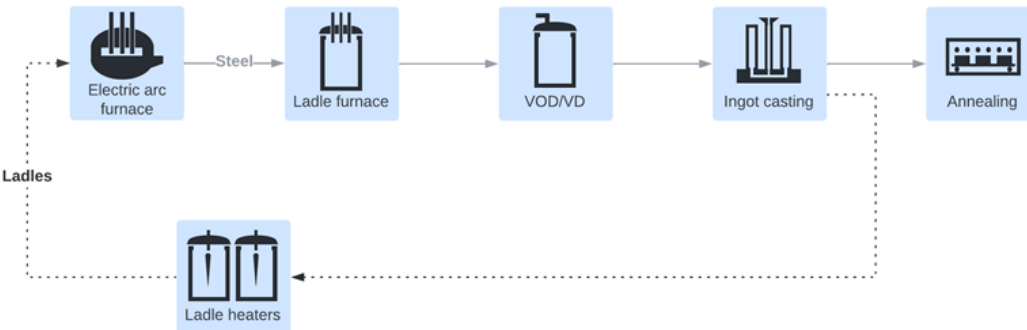
Figure 2. Production process scheme of the considered EAF steel mill.